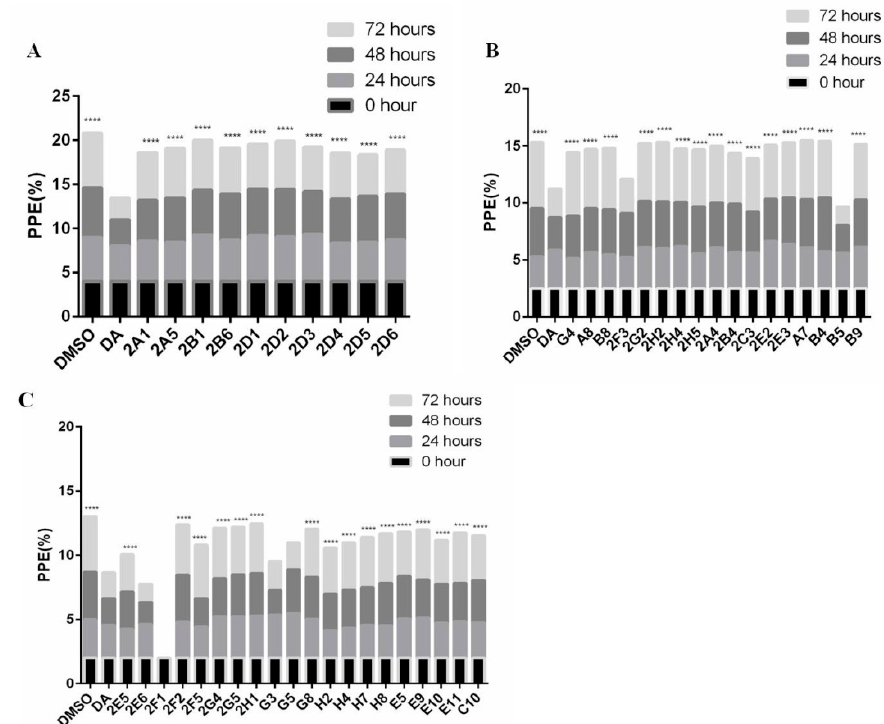
Figure 3. The rescreening of 47 natural products against B. microti by in vitro culture. The asterisks indicate statistically significant differences between the treated and control groups (**** p < 0.0001). ( A ) The natural products of 2A1, 2A5, 2B1, 2B6, 2D1, 2D2, 2D3, 2D4, 2D5 and 2D6. ( B ) The natural products of G4, A8, B8, 2F3, 2G2, 2H2, 2H4, 2H5, 2A4, 2B4, 2C3, 2E2, 2E3, A7, B4, B5 and B9. ( C ) The natural products of 2E5, 2E6, 2F1, 2F2, 2F5, 2G4, 2G5, 2H1, G3, G5, G8, H2, H4, H7, H8, E5, E9, E10, E11 and C10.